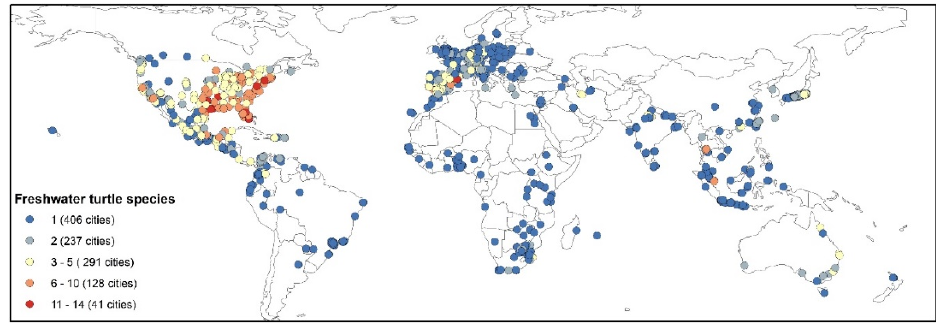
Figure 3. Number of freshwater turtle species sighted between January 2013 and April 2018 within 50 km of a city with a population of more than 100 000.